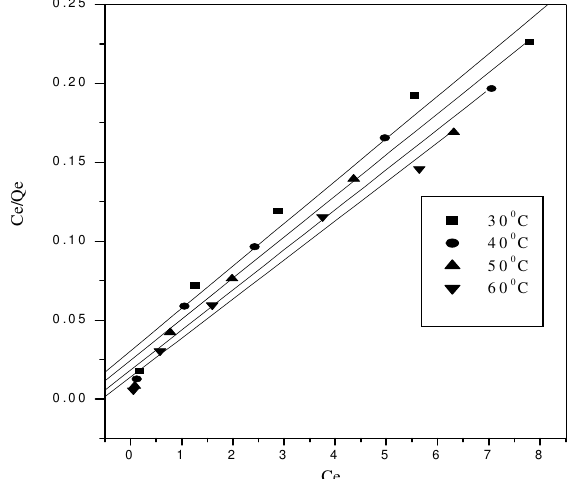
Figure 3. Linear Langmuir isotherm for the adsorption of ferrous ion onto